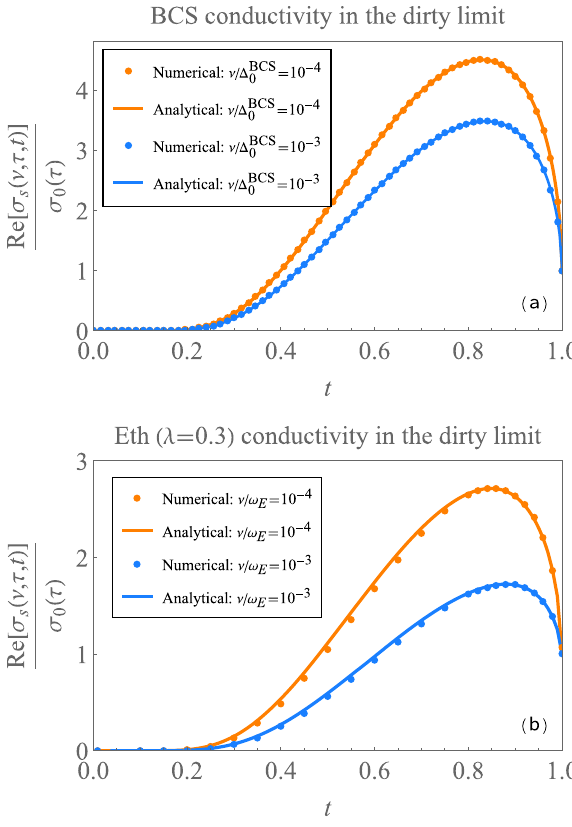
Fig. 2 The conductivity ratio versus t ≡ T / T c in the dirty limit. a BCS Fig. 1 Electrical conductivity plots. a Normalized ratio of the real part of theory results. The numerical results are computed using Eq. (2.12) and the the superconducting conductivity to the normal-state conductivity ( σ s / σ n ) solid curves are obtained using Eq. (2.16). b Eliashberg theory results for in Eliashberg theory (Eth) versus reduced temperature t ≡ T / T c for various λ = 0.3, T c / ω E = 0.009923. The numerical results are computed using Eq. inverse scattering values 1/( τω E ). The numerical results are obtained using (2.11) and the solid curves are obtained using Eq. (2.17). Eq. (2.5), with electron-phonon coupling λ = 1, external frequency ν / ω E = 0.01, where ω E is the Einstein frequency. The bottom curve corresponds to 1/( τω E ) = 0.01 (the clean limit) and the top curve is 1/ ( τω E ) = ∞ (the dirty limit). The value of 1/( τω E ) increases upwards from the bottom curve to the top curve. b The same quantity as in a , but now in (cid:1) (cid:3) ¼ 1 . The blue numerical result is the same as in the dirty limit 1 = τω E a , and the analytical blue curve is obtained using Eq. (2.17). The orange curves show the numerical and analytical results for a lower frequency ν / ω = 10 − 4 E